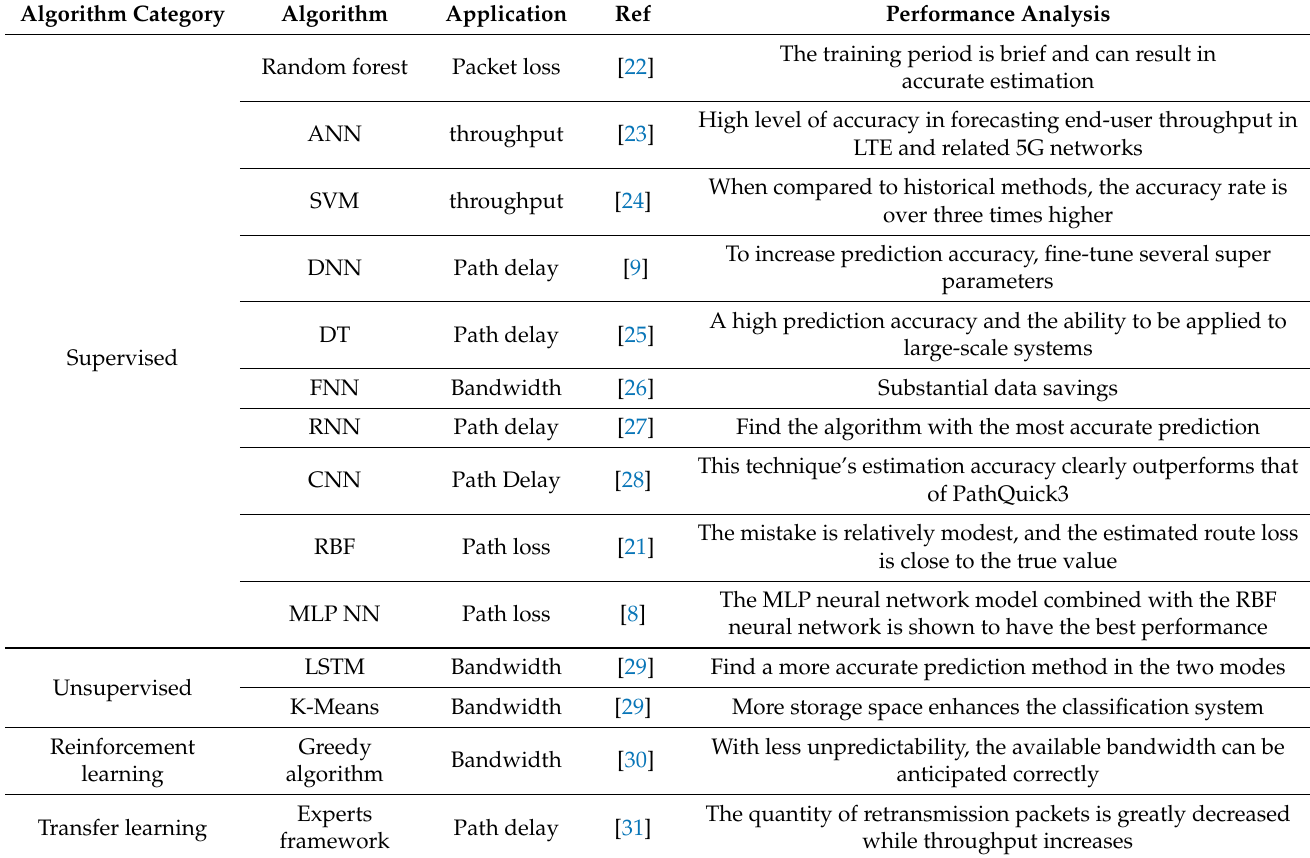
Table 1. Application of Network Measurement and analysis of ML